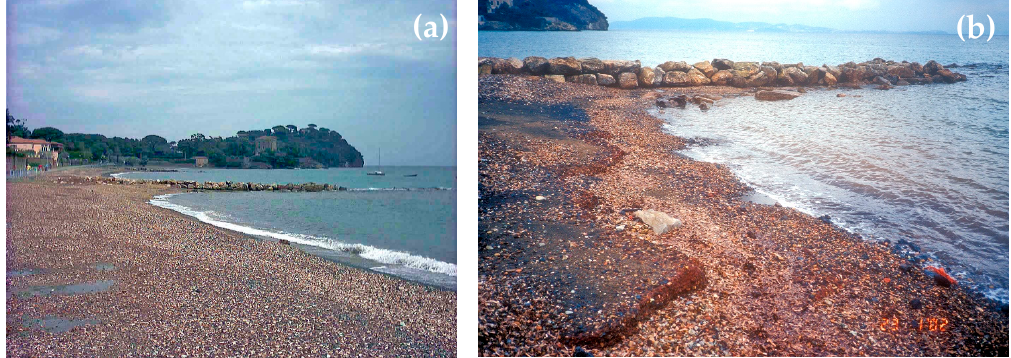
Figure 4. The beach at Cavo in January 2002, after the nourishment performed with iron rich materials with puddles showing the low permeability of the sediments ( a ); outcropping of the consolidated and impermeable fill material layer ( b